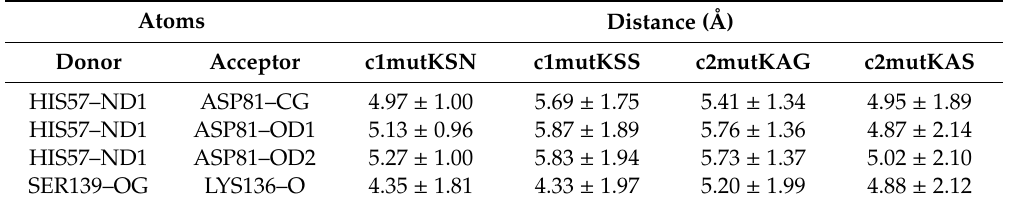
Table 3. Distance between